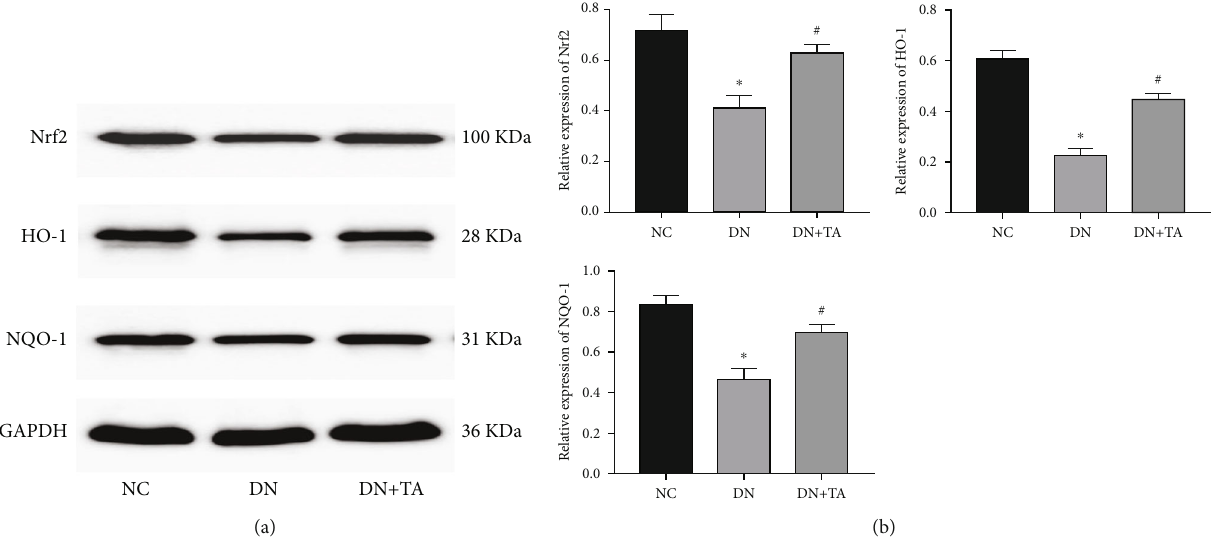
Figure 4: TA administration alleviated oxidative stress by activating Nrf2/HO-1 pathway in DN. (a) Representative western blots for Nrf2, HO-1, and NQO-1 protein expressions. (b) The quanti fi cation of Nrf2, HO-1, and NQO-1 protein expressions. All data are presented as mean ± SD . ∗ P < 0 : 05 versus NC group; # P < 0.05 versus DN